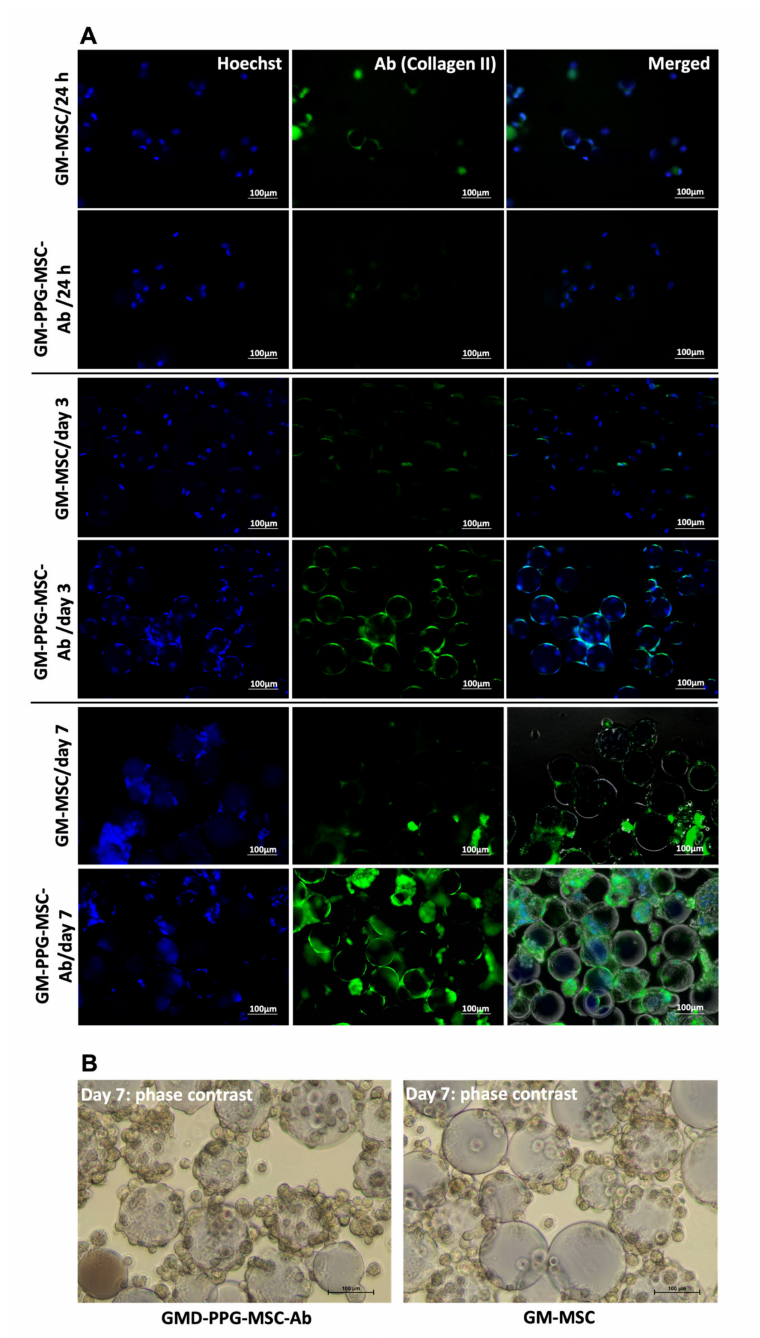
Figure 6. The efficiency of antibody conjugation to GM-PPG-MSCs. ( A ) Immunofluorescence staining of Hoechst dye (nucleus staining) and green fluorescent staining of type II collagen on a 3D culture. ( B ) Phase-contrast images of GM-PPG-MSCs-Ab and GM-MSCs groups that show MSCs attachment and proliferation on the surface of the GM. Scale bar measures 100 µ